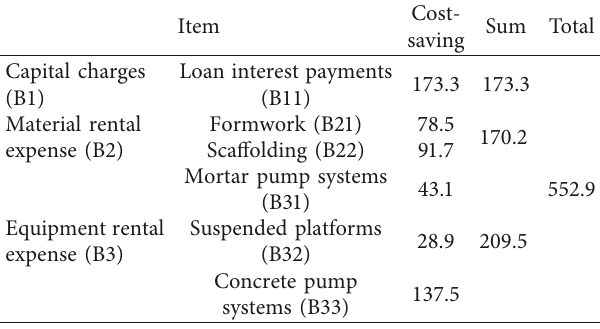
Table 3: Results of economic merits brought by resource-savings (¥/m 2 ).